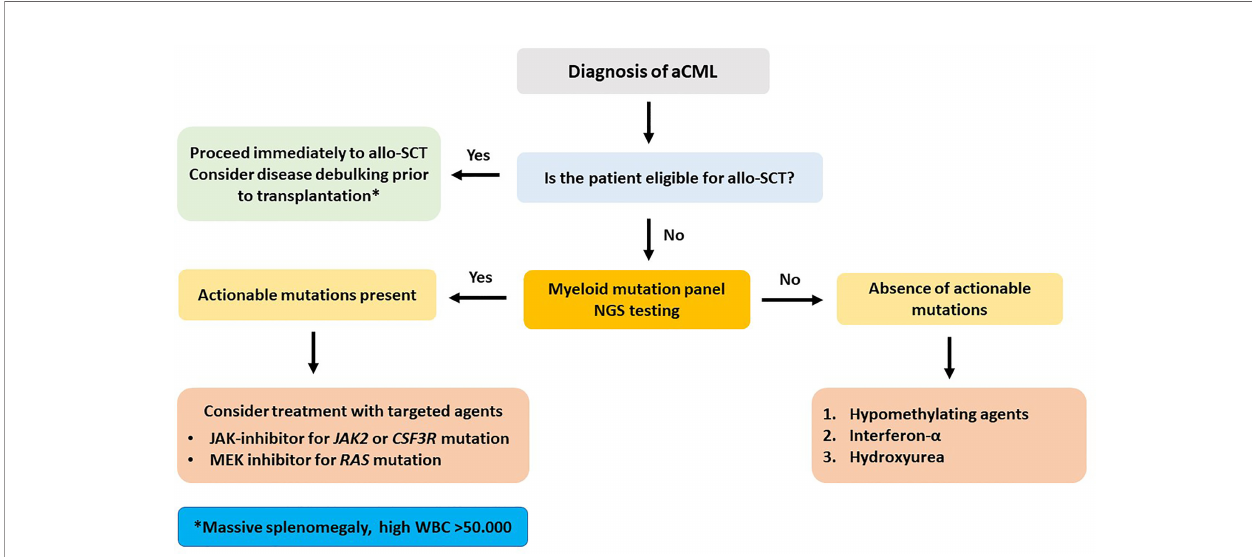
FIGURE 3 | Recommended treatment algorithm for patients with atypical chronic myelogenous leukemia. Massive splenomegaly and extreme leukocytosis at the time of initial diagnosis bear a severely dismal prognosis.